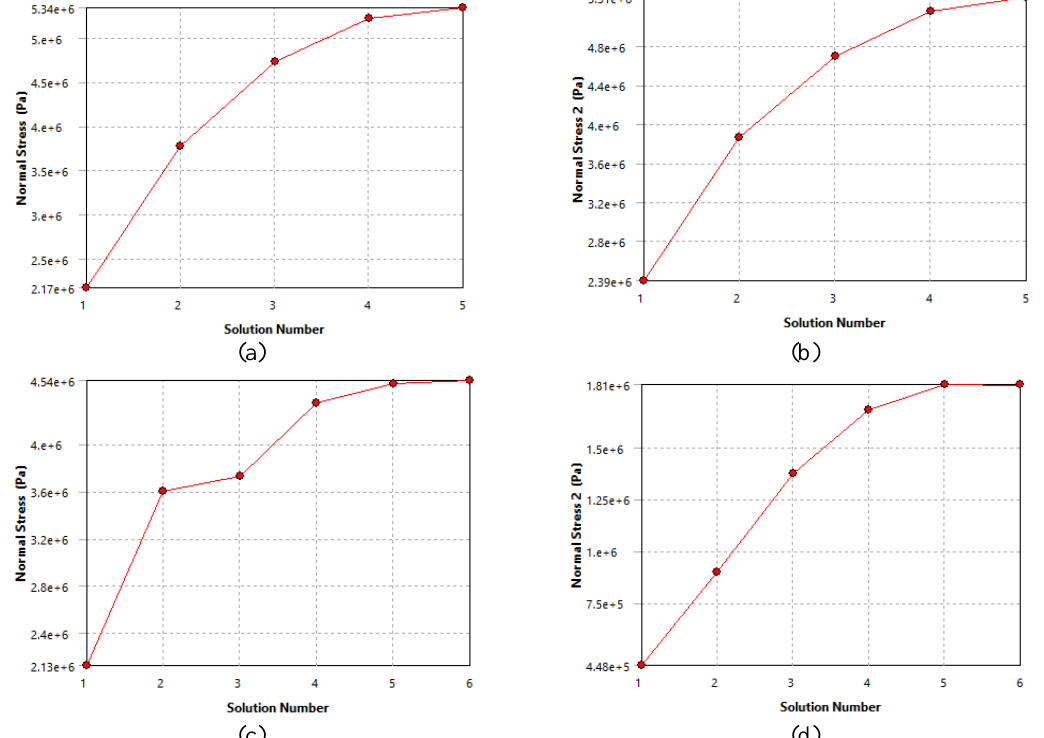
Figure 3. Convergence behaviour of the FE model for r/a = 0.05 under (a) - (b) biaxial loading and (c) – (d) uniaxial